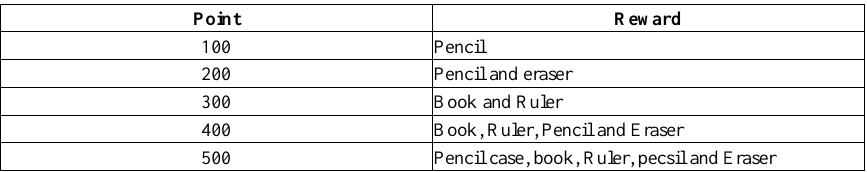
Table 3. Table Point and